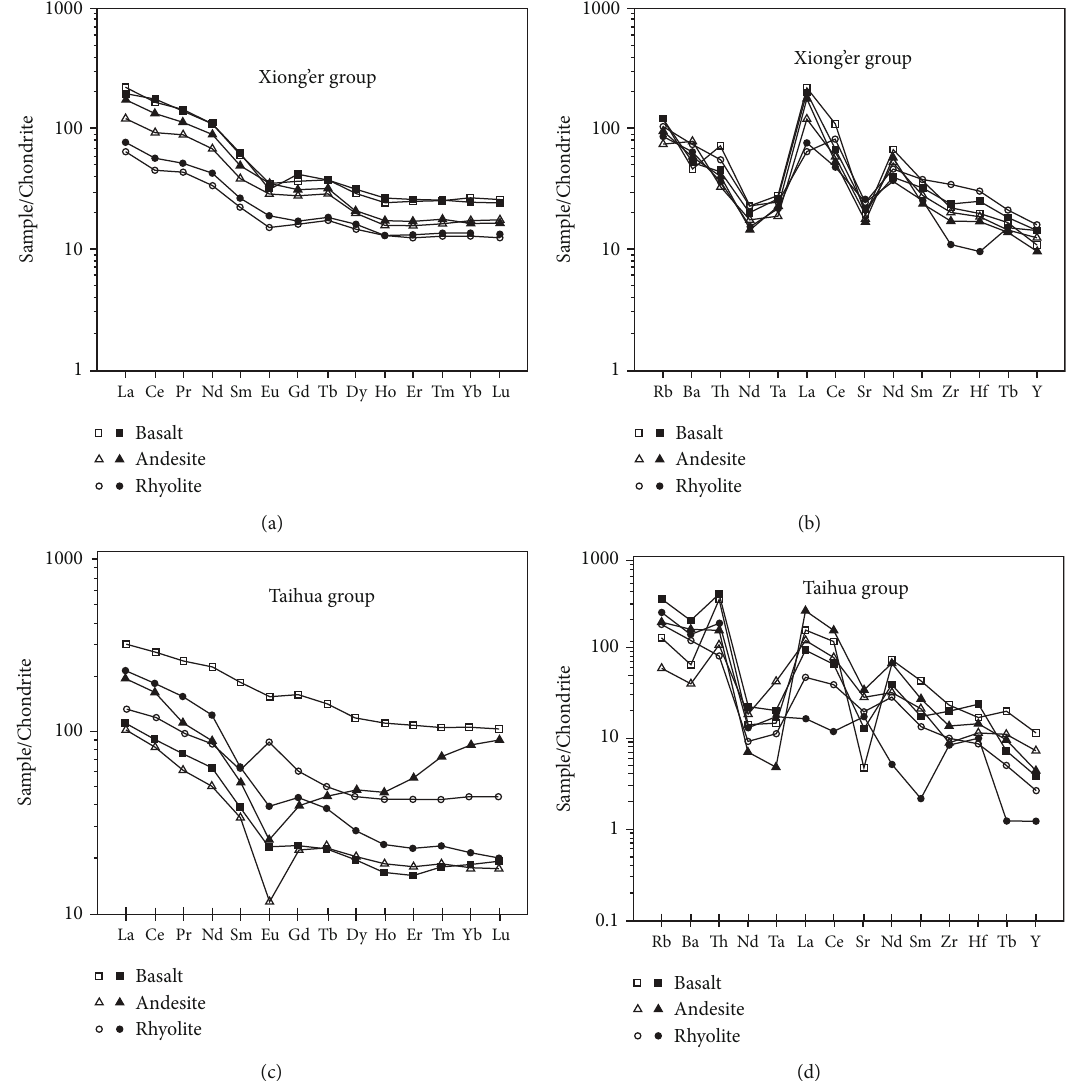
Figure 9: (a, c) Chondrite-normalized REE patterns and (b, d) trace element spider diagram of the Xiong ’ er Group and Taihua Group. Data source: [1, 8, 14, 25,